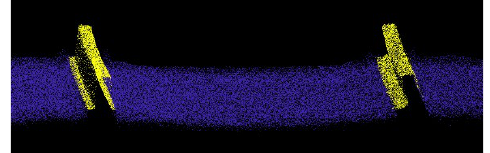
Figure 10. Manual segmentation of the